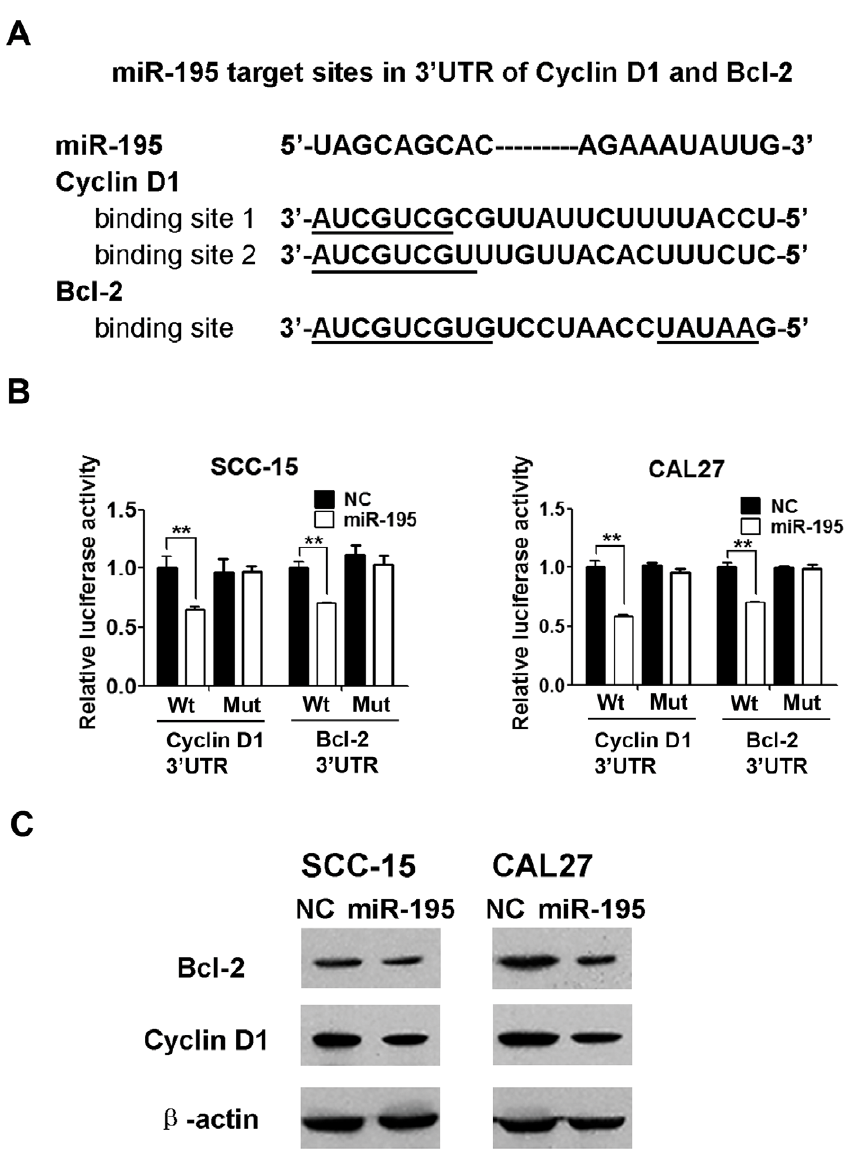
Figure 5. Cyclin D1 and Bcl-2 are direct targets of miR-195. (A), Sequence alignments of miR-195 and its target sites in 3 9 -UTRs of Cyclin D1 or Bcl-2. (B), Targeting of 3 9 -UTRs of Cyclin D1 or Bcl-2 by miR-195. SCC-15 and CAL27 cells were co-transfected with firefly luciferase reporter plasmids containing wildtype (Wt) and mutant wildtype and mutant (Mut) 3 9 -UTRs of Cyclin D1 or Bcl-2, and pRL-TK plasmid (a plasmid expressing rellina luciferase) and pcDNA3.0-miR-195 (miR-195) or pcDNA3.0 as indicated. After 48 h, firefly luciferase activities were measured and normalized by renilla luciferase activities. Data were presented as mean 6 SD (n=3) ( ** P , 0.01). (C), Inhibition of protein expression of Cyclin D1 and Bcl-2. SCC-15 and CAL27 cells were transfected with pcDNA3.0 as a negative control (NC) or with pcDNA3.0-miR-195 (miR-195) as indicated. After 48 h, Cyclin D1, Bcl-2 and internal control b -actin were detected by Western blotting.